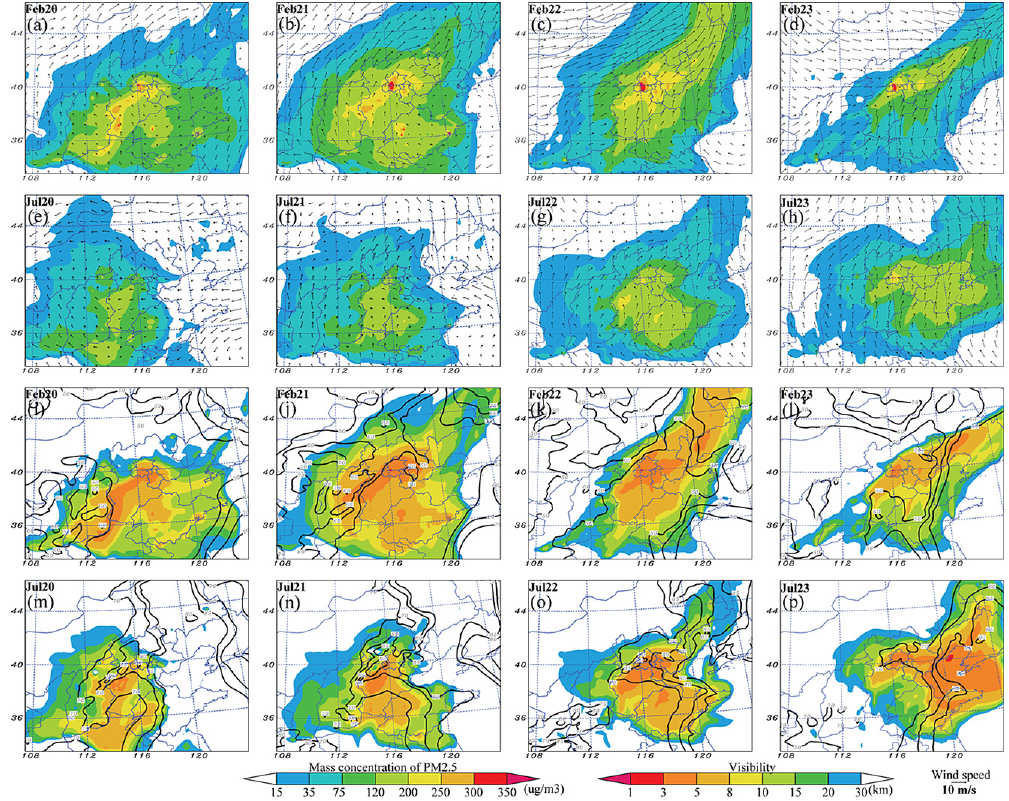
Figure 12. The horizontal distributions of the daily-average mass concentration of PM 2 . 5 (µgm − 3 ; a–h ) and visibility (km; i–p ) from 20 to 23 February and 20 to 23 July over the NCP. Also shown are the wind field (arrows) and the relative humidity (%; black contour